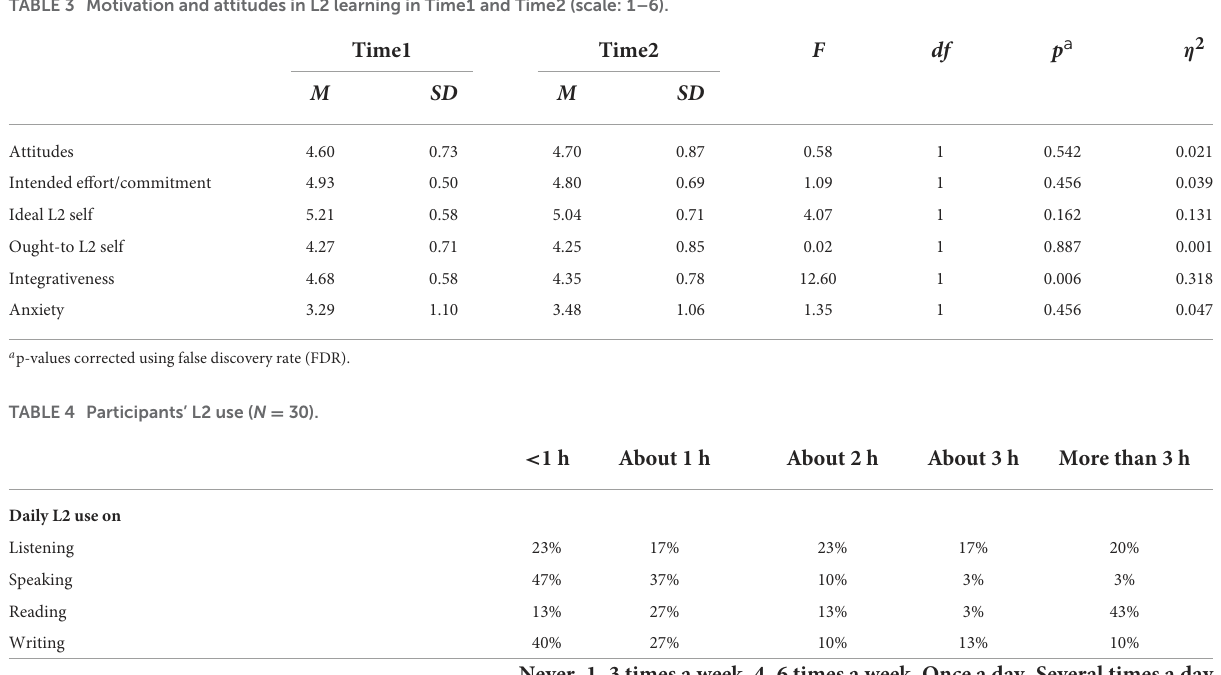
TABLE 3 Motivation and attitudes in L2 learning in Time1 and Time2 (scale: 1–6).